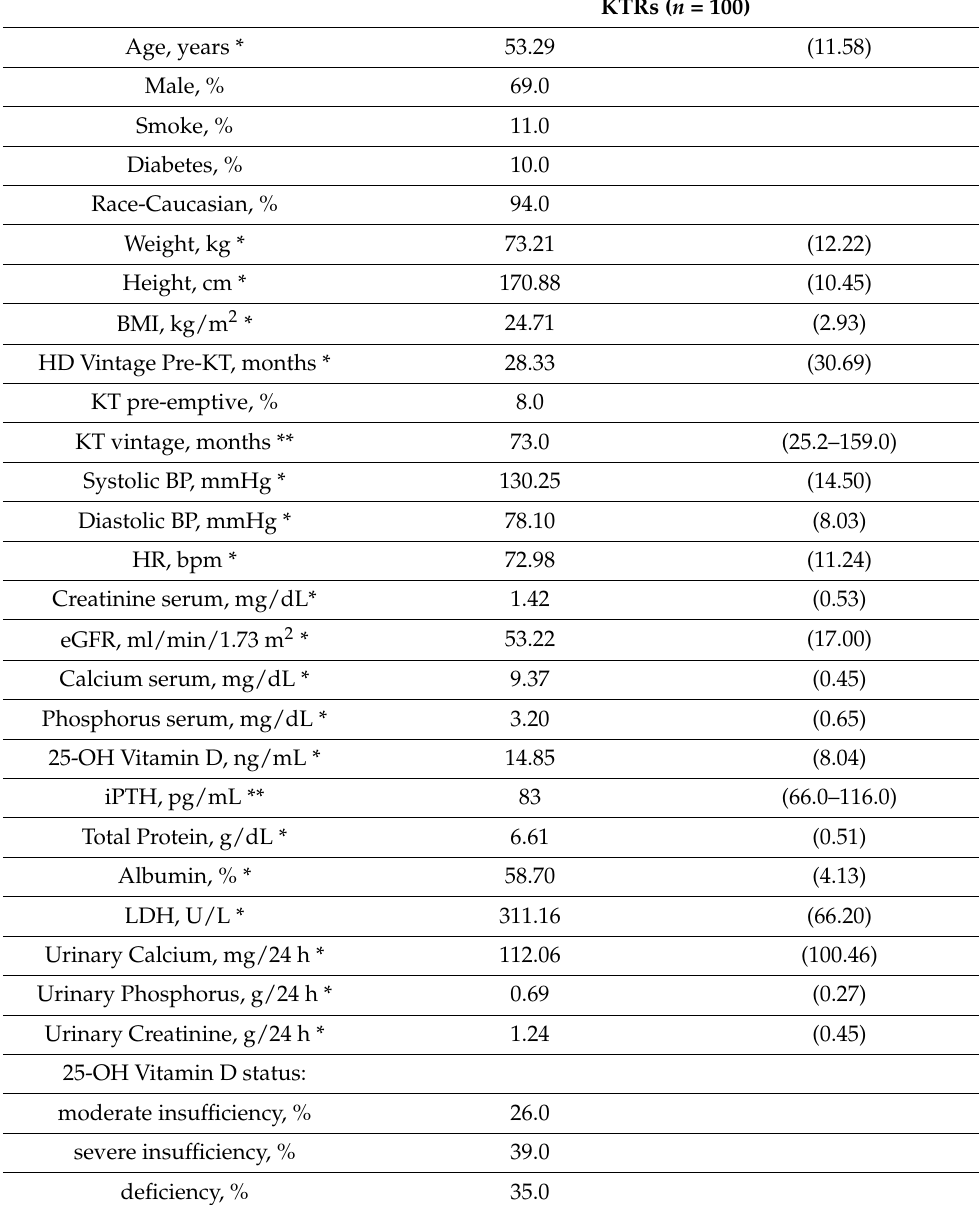
Table 1. Demographic and biochemical data of kidney transplant recipients (KTRs) at